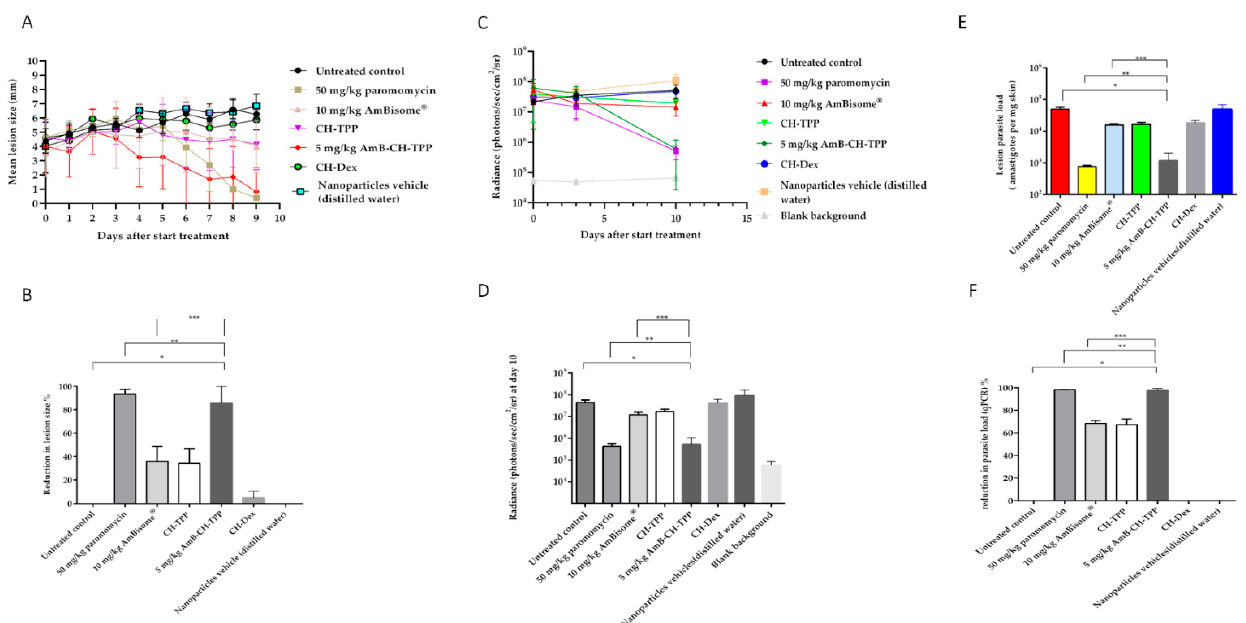
Figure 2. AmB nanoparticles efficacy in the lesion cure model in BALB/c mice infected with luciferase-expressing L. major parasites. L. major infected mice were allocated into 8 groups: (G1) represents untreated infected group, (G2) paromomycin as a positive control (50 mg/kg/QD for 10 days; i.p.), (G3) AmBisome ® as a comparison group (10 mg/kg/QAD for 10 days; i.v.), (G4) CH-TPP nanoparticles (mass of nanoparticles in the blank formulations reflected the related AmB-loaded ones) (QAD for 10 days; i.v.), (G5) AmB-CH-TPP nanoparticles (5 mg of AmB/kg/QAD for 10 days; i.v.), (G6) CH-Dex nanoparticles (mass of nanoparticles in the blank formulations reflected the